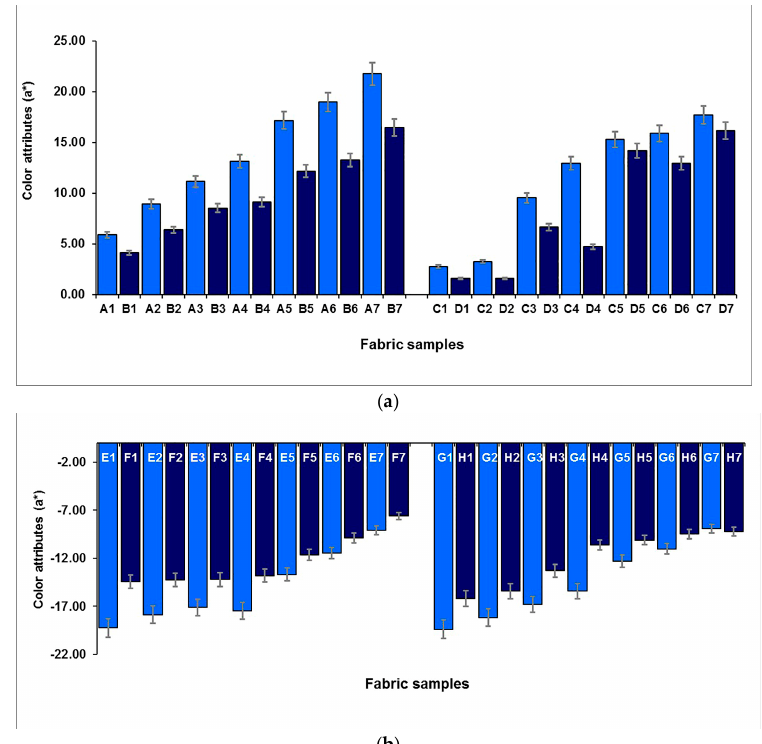
Figure 11. Effect of weft density on the redness and greenness of ( a ) blue-red mixed fabrics; ( b ) yellow-green mixed fabrics.